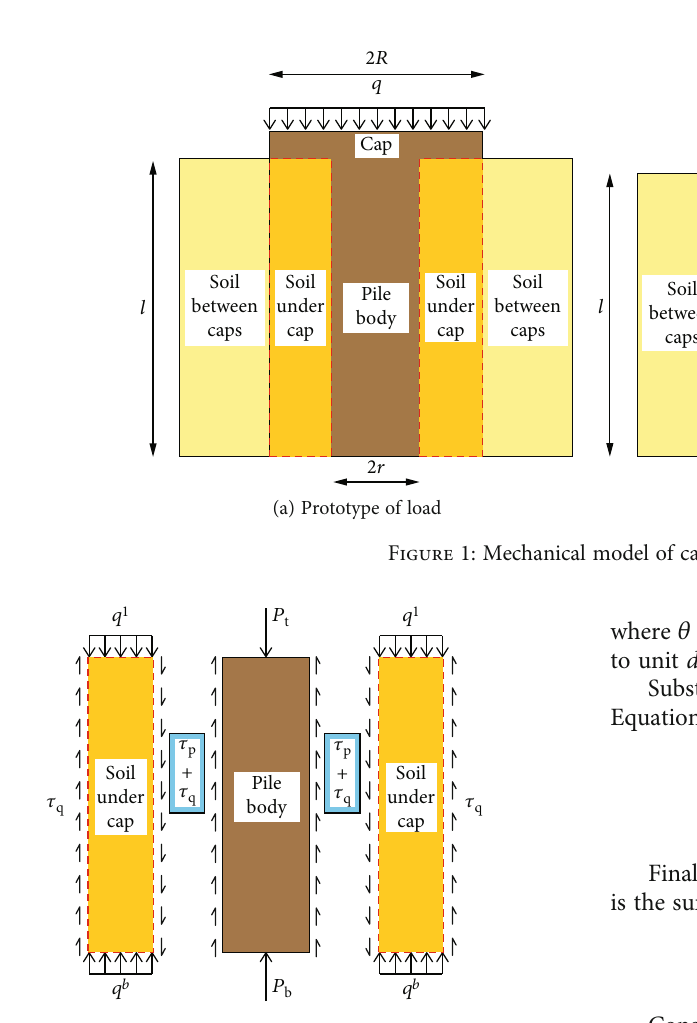
Figure 2: Pile – soil interaction analysis